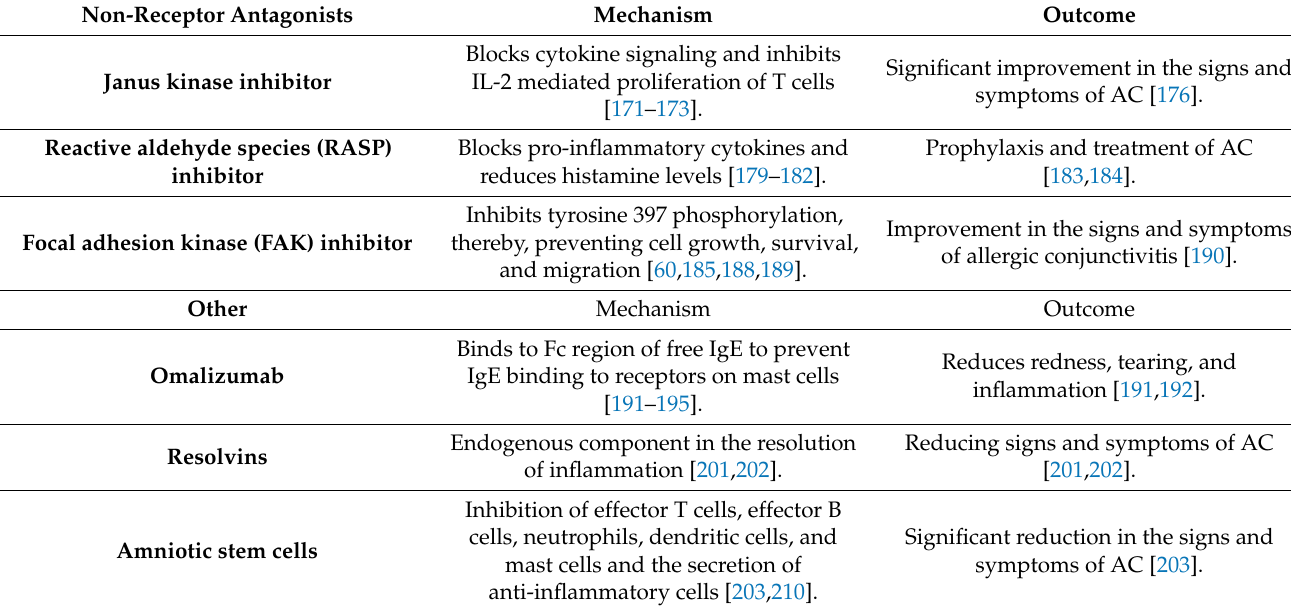
Table 3. Additional potential therapeutic targets in allergic